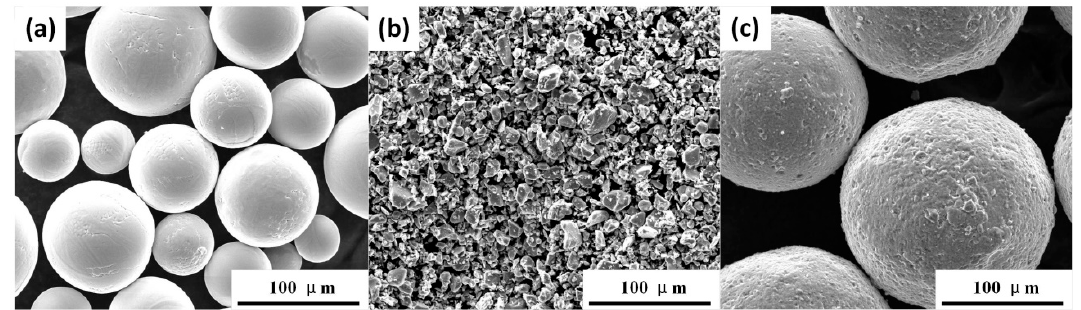
Figure 1. The scanning electron microscopy micrographs of initial powders: ( a ) TA15 powders; ( b ) TiB 2 particles; ( c ) mixed powders.